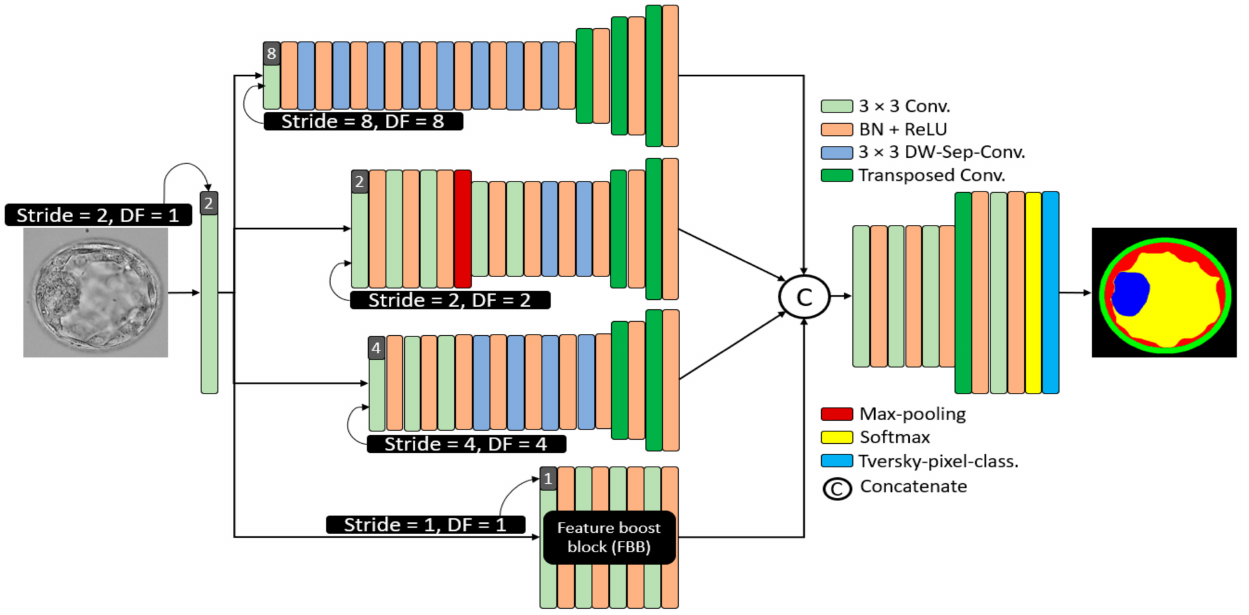
Figure 3. The architecture of the proposed MASS-Net. Here in this figure 3 × 3 kernel convo- lution (3 × 3 conv.), batch normalization in combination with rectified linear unit (BN + ReLU), 2 × 2 transposed convolutions with stride = 2 (Transposed Conv.), and 3 × 3 kernel-based DWSC